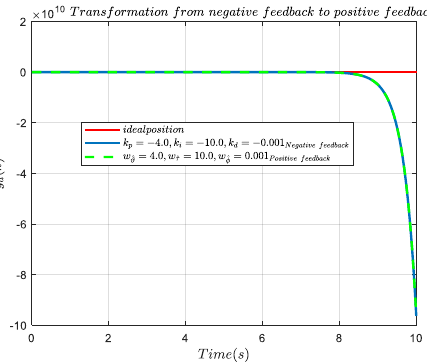
Figure 5. PID control strategy with negative parameters and step response of the corresponding equivalent positive feedback.